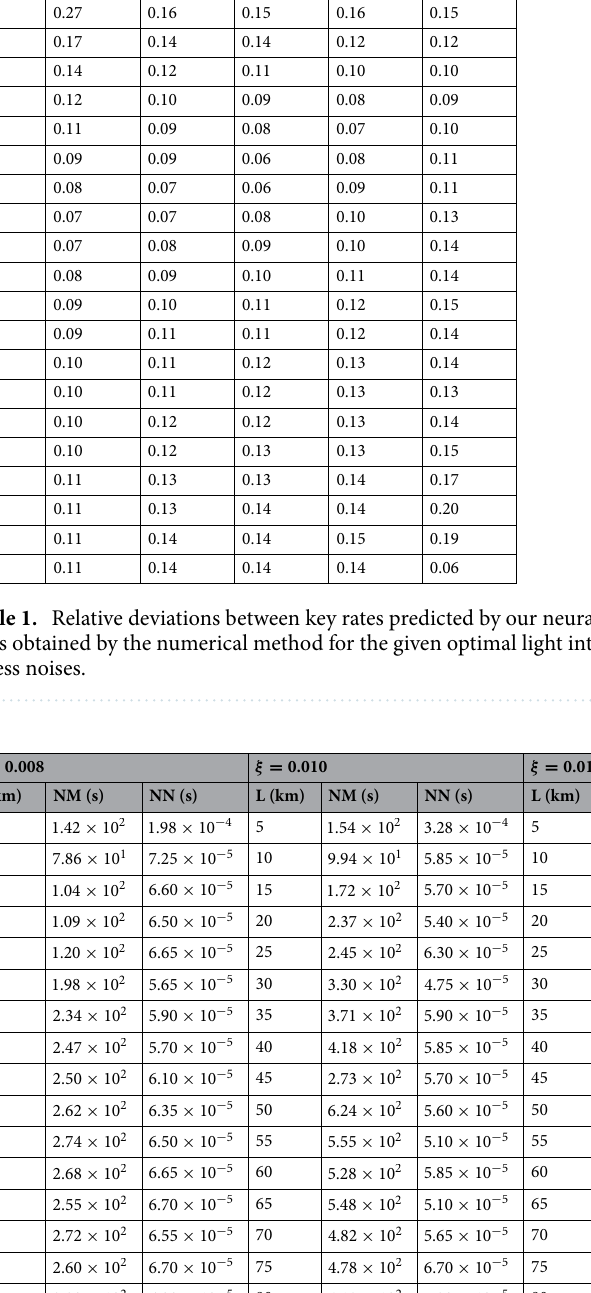
Table 2. Time consumption of the neural network versus the numerical method with excess noise ξ of 0.008, 0.010 and 0.012. NM and NN are the abbreviations of the numerical method and neural network, respectively. L is the distance between Alice and Bob.